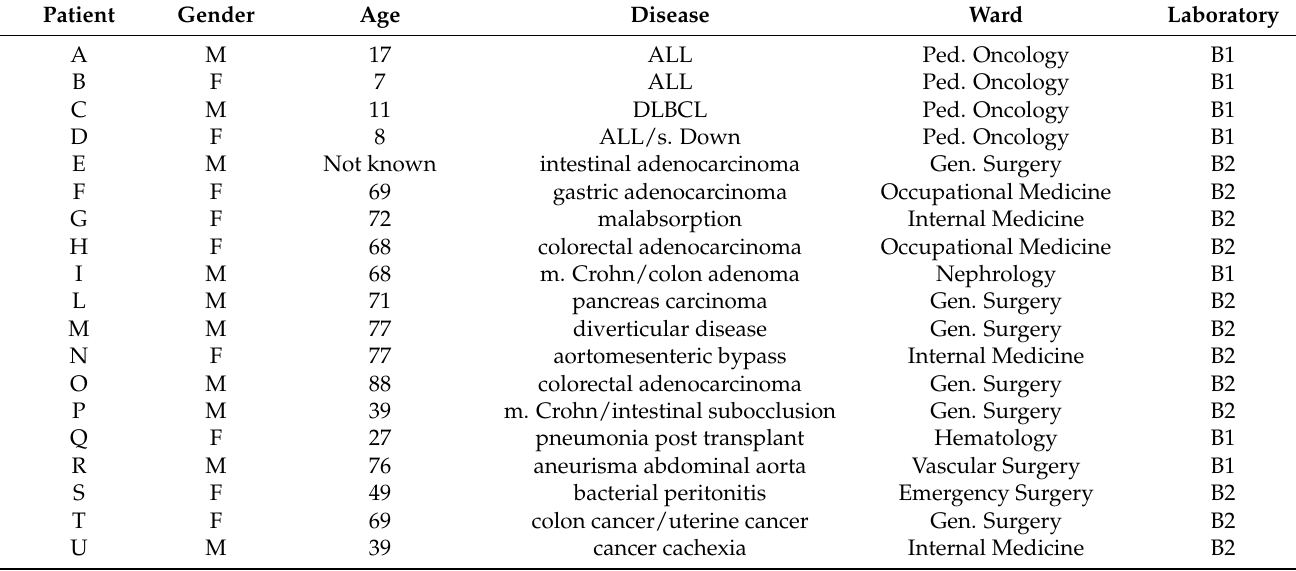
Table 1. Patients listed by gender, age, disease, ward and the laboratory that tested their blood samples.